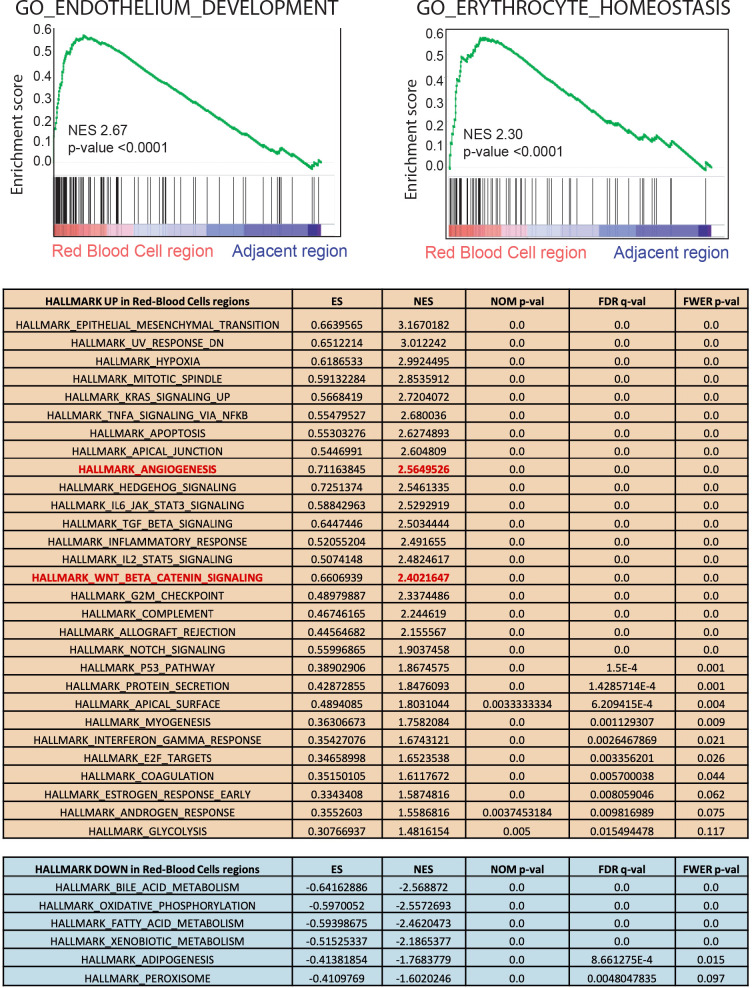
Peliosis-like regions from [Apc-Arid1a]ko-focal livers are enriched for ‘Endothelium development’ and ‘Erythrocyte homeostasis’ transcriptional signatures.Gene-set enrichment analysis (GSEA) was performed with the Java tool application available at the Broad Institute (Cambridge, MA, USA) in which FFPE micro-dissected RBC regions were compared with neighboring tissue. ES: enrichment score, NES: normalized enrichment score, NOM p-val: nominal p-value, FDR: false discovery rate, FWER p-val: familywise-error rate p-value. Transcriptomic gene-set enrichment analysis (GSEA) of hepatic peliosis (n = 4) relative to adjacent regions (n = 4) of [Apc-Arid1a]ko-focal mice showing endothelium and erythrocyte signatures. The table below is a GSEA using the hallmark database.